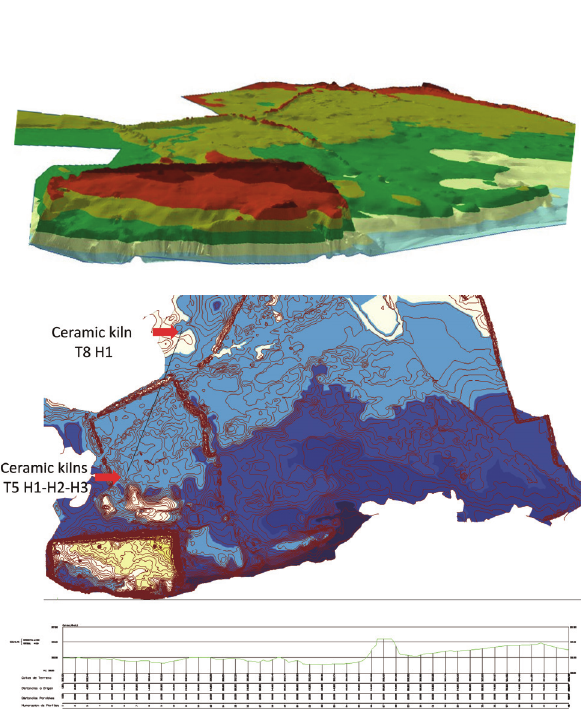
Figure 4. Interpolated 3D model of current period with the location of the ceramic kilns (above). Longitudinal section on the DEM between the T5 and T8 area of ceramic kilns